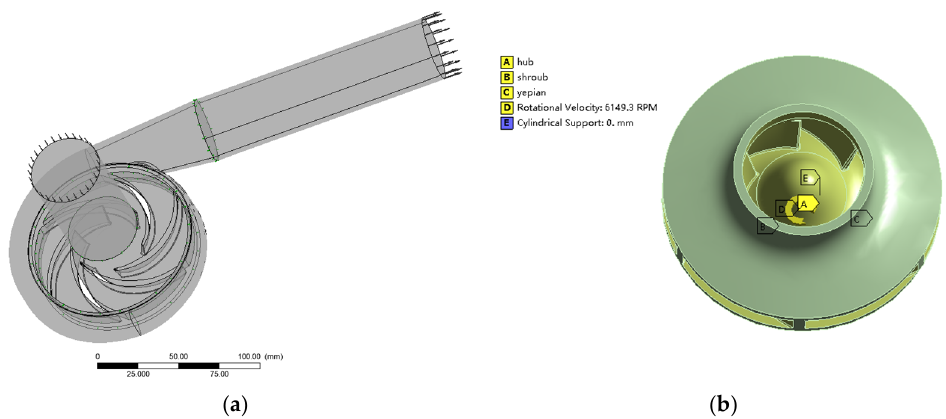
Figure 6. Fluid domain and impeller solid domain of centrifugal pump; ( a ) Fluid domain, ( b ) Solid domain.